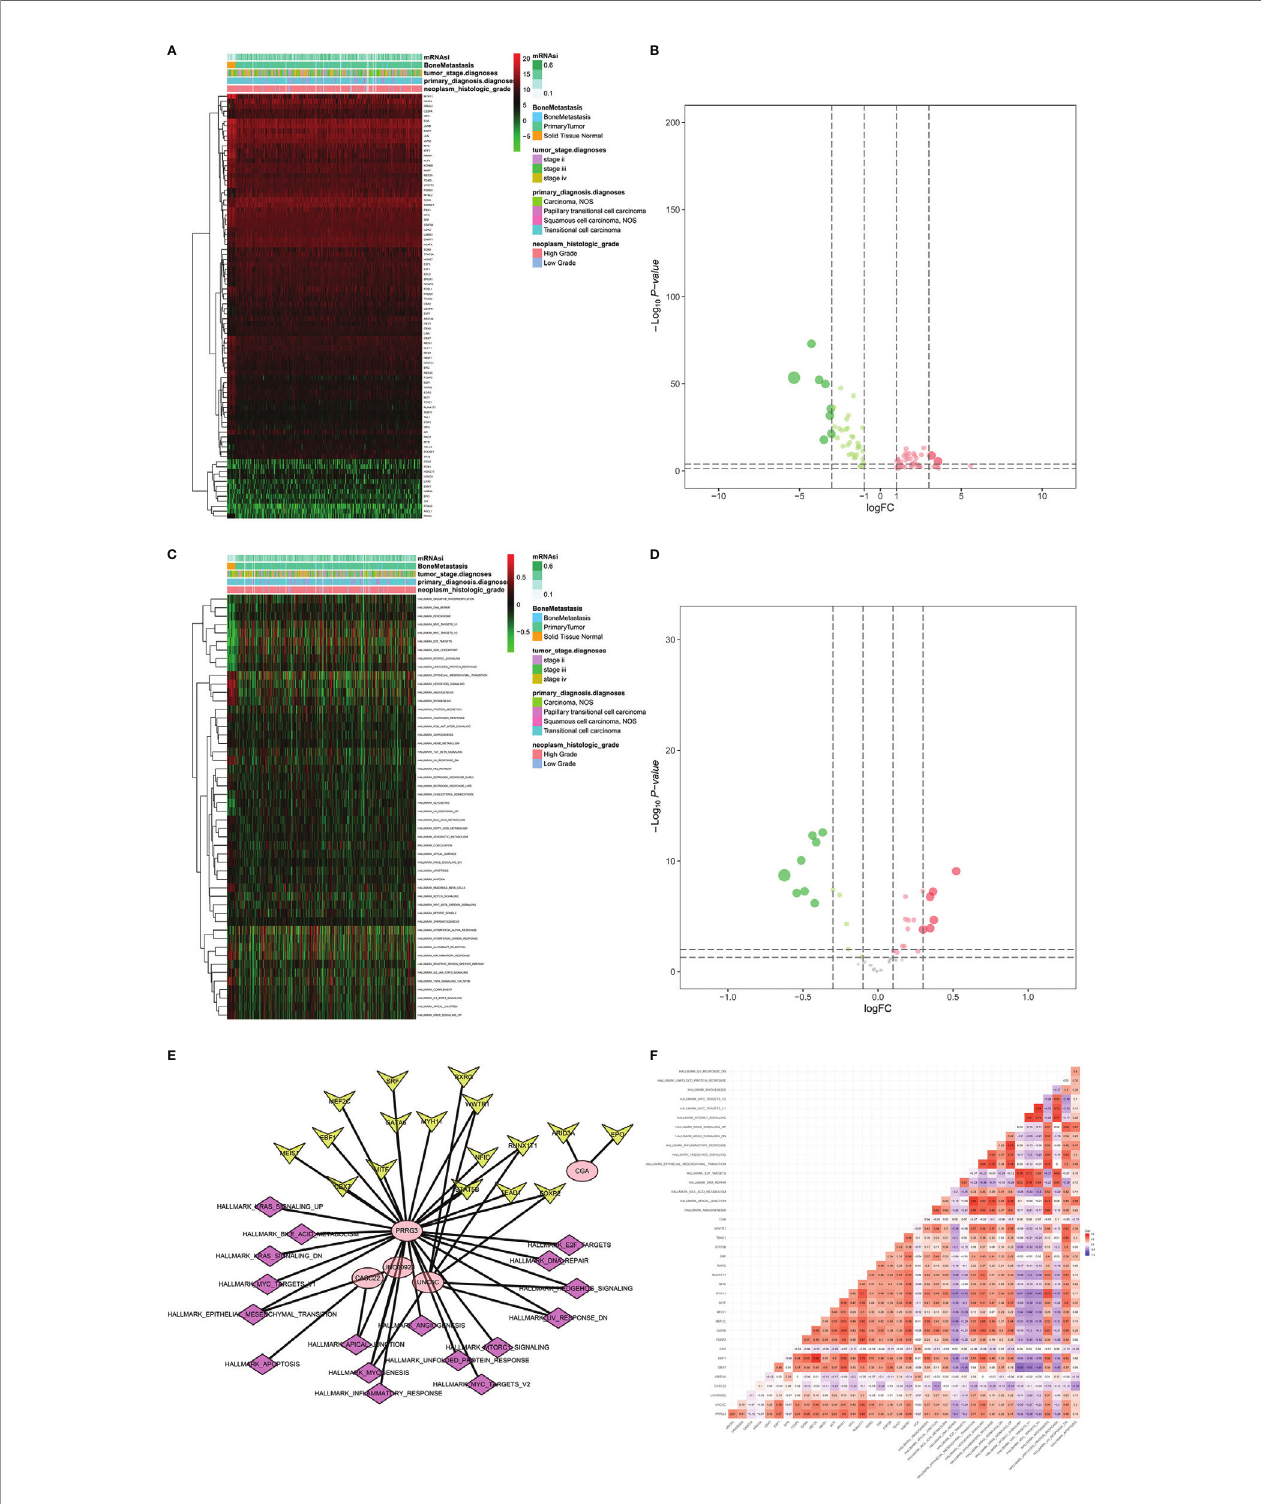
FIGURE 9 | Identi fi cation of the PRSGs co-expressed upstream TFs, the downstream hallmarks of cancer gene sets. The heatmap (A) and volcano plot (B) of differentially expressed TFs between primary BLCAs and normal solid tissue samples. The heatmap (C) and volcano plot (D) of differentially expressed hallmarks of cancer gene sets between primary BLCAs and normal solid tissue samples. The point to point co-expression analysis (E) and co-expression interaction pairs (F) between TFs, PRSGs, and hallmarks of